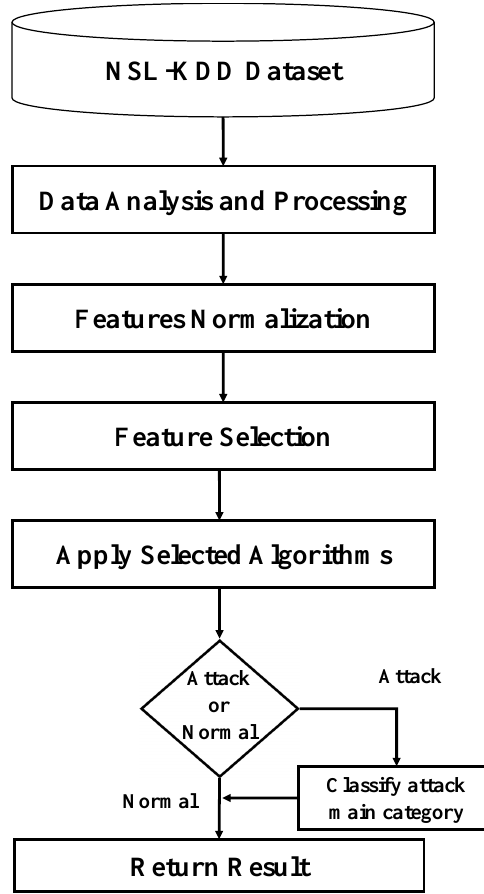
Figure 2. Proposed System Architecture. This flow chart represents the overall process. The process starts with the data source, the NSL-KDD dataset, followed by data analysis and some pre-processing techniques for data cleaning. Feature normalization and feature selection are performed in order to implement the later selected tree-based machine learning algorithm to classify whether there is an attack or not and the types of